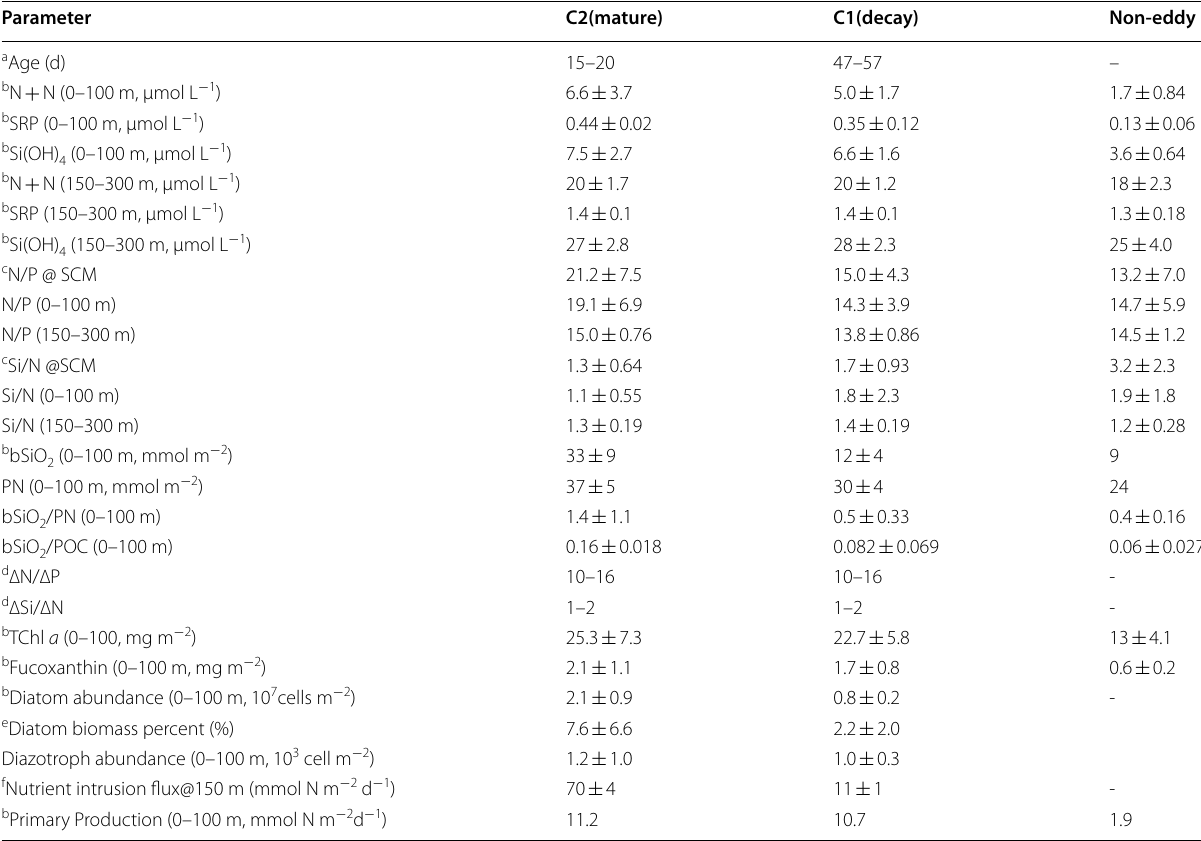
standard deviation) in both dissolved and particulate phases, and biomass ±